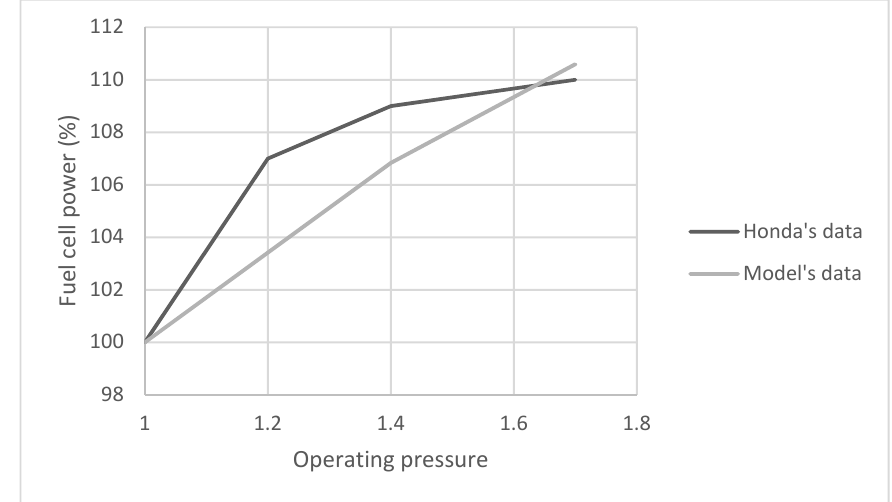
Figure 9. Comparison between Honda’s data and the model’s data of the operating pressure influence on the output power.